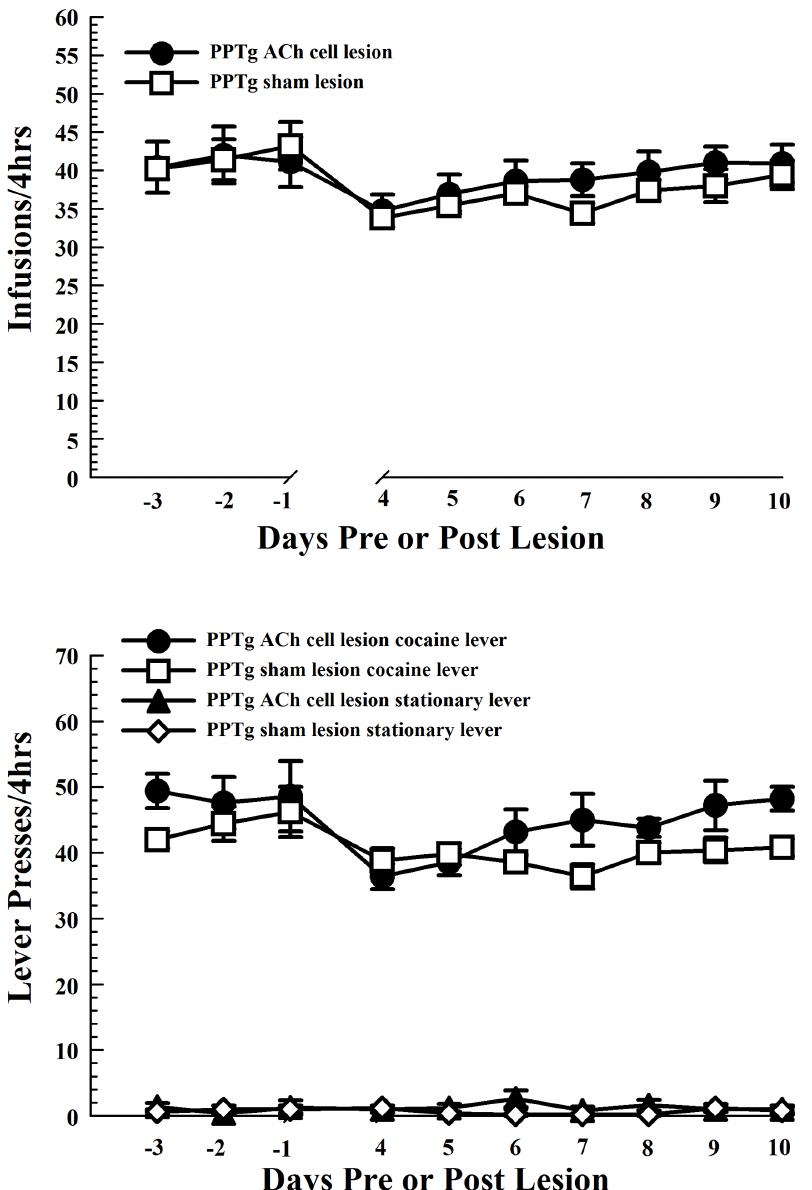
Figure 1. Intravenous self-administration of cocaine is not altered by bilateral PPTg cholinergic cell loss. Bilateral PPTg cholinergic cell lesions (solid circles; n=5) did not significantly affect cocaine self-administration relative to sham lesions (open squares; n=5), either in terms of the number of cocaine infusions in daily sessions (top) or the number of active lever presses to attain those infusions (bottom panel). All rats showed a decrease in cocaine intake on the first post-lesion testing day that returned to pre-lesion baseline levels by the third post-lesion testing day. The ability to distinguish between the retractable and stationary levers was not compromised by PPTg cholinergic cell loss. Error bars represent 6 SEM.